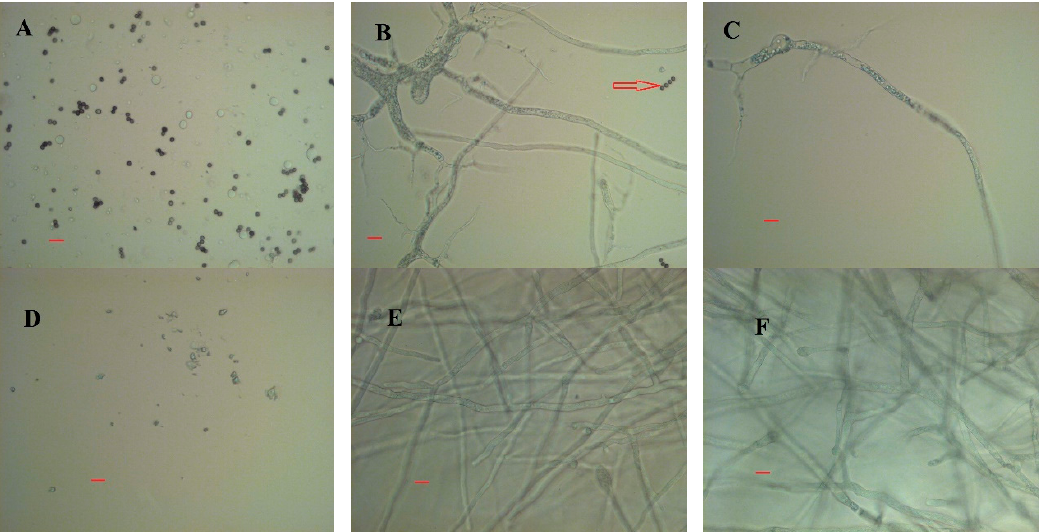
Figure 7. Microscopic morphology of M. indicus in airlift bioreactor after cultivation for ( A ) 0 h, ( B ) 24 h, and ( C ) 48 h. The D – F pictures belonged to R. oryzae growth ( D ) at the beginning, ( E ) after 48 h, and ( F ) 72 h. Both fungi were cultivated on CWFS in airlift reactors with no additional nutrients. The bars correspond to 20 μ m.